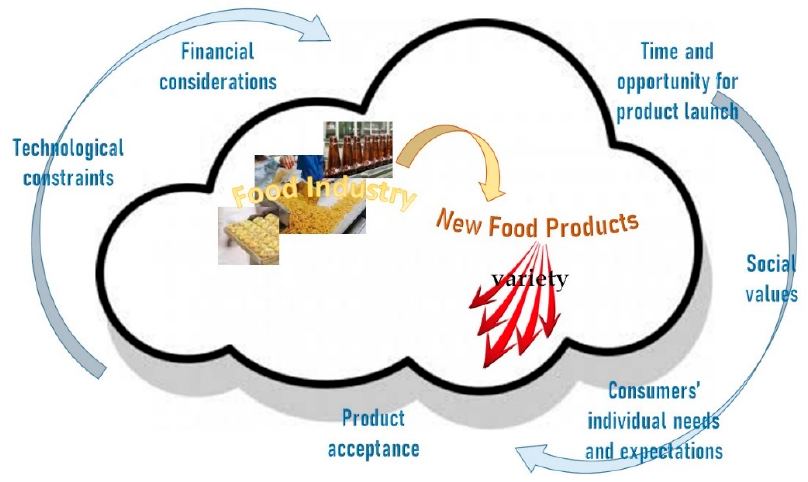
Figure 1. Industrial food development strategy (author’s own work).